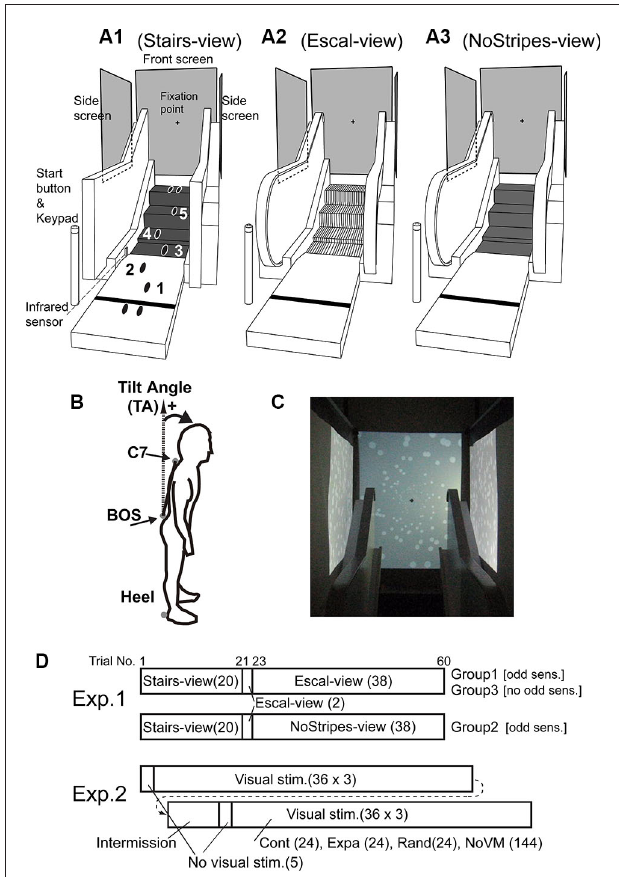
FIGURE 1 | Experimental setups using escalator mock-up . (A1) Stairs-view condition, in which the handrail was covered with a black cloth with rectangular corners (to change the rounding shape of the handrail) and tread-boards were covered with black rubber sheets. (A2) Escal-view condition, in which the escalator aperture was fully viewed. (A3) NoStripes-view condition, in which tread-boards were veiled. Back-projected vertical screens were placed in the front and at bilateral sides. A fixation marker was shown around the center of the frontal screen during trials. (B) Marker locations for posture measurements [C7 of the spine, basis ossissacri (BOS), and right and left heels]. Tilt angle (TA) was calculated by the angle difference between the line C7 connecting BOS and the vertical axis. (C) White disk patterns for contraction/expansion/random motion stimuli on the frontal screen and for forward/backward/random motion stimuli on the bilateral screens. (D) Stimulus conditions throughout the trials in Experiments 1 and 2. Number of trials in each condition is indicated in parenthesis. In the first trial in the Escal-view condition, participants in Groups 1 and 2 reported the odd sensation, and participants in Group 3 did not. “Visual stimuli” in Experiment 2 consisted of static (NoVM), contraction (Cont), expansion (Expa), and random (Rand) stimulus conditions, randomly ordered.